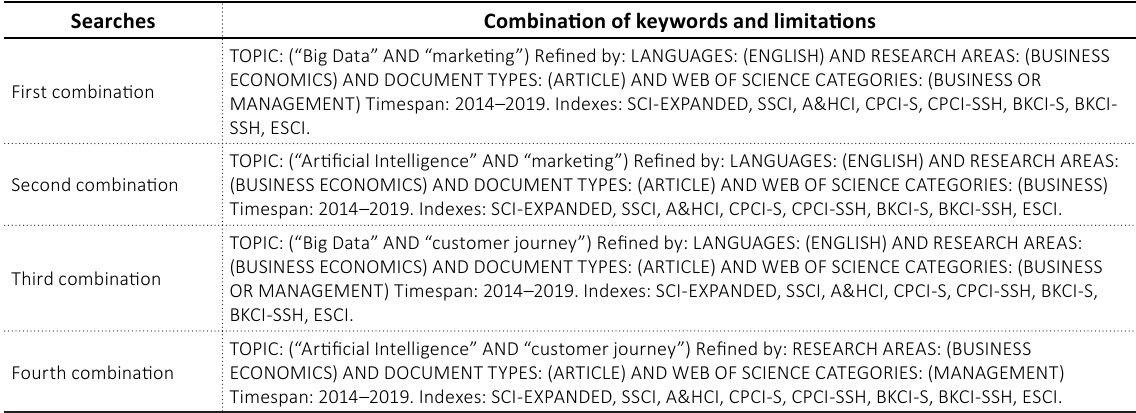
Table 2. Combination of keywords and limitations in the Web of Science database Searches